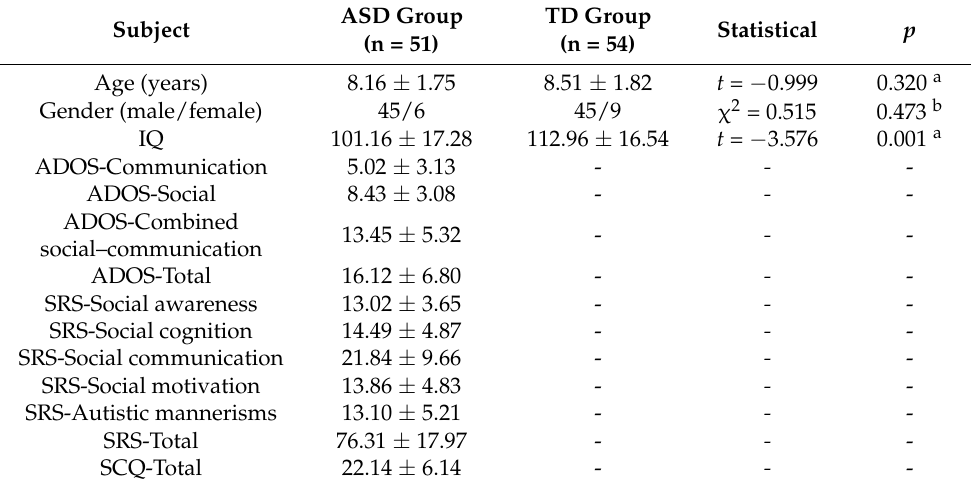
Table 1. Clinical and demographic characteristics of all